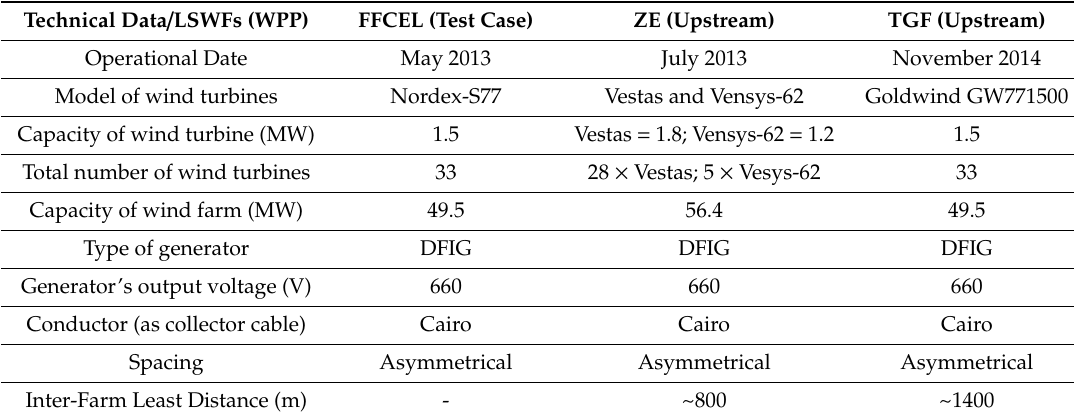
Figure 1. MATLAB/SIMULINK base case test system with three integrated wind farms. Figure 1. MATLAB / SIMULINK base case test system with three integrated wind farms. Table 1. Technical specifications of the test system under study (consisting of three WFs)